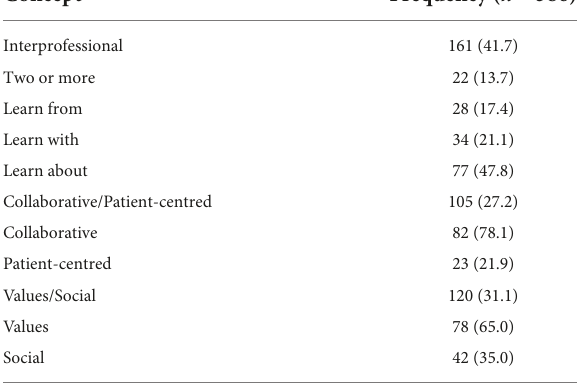
TABLE 1 Citation